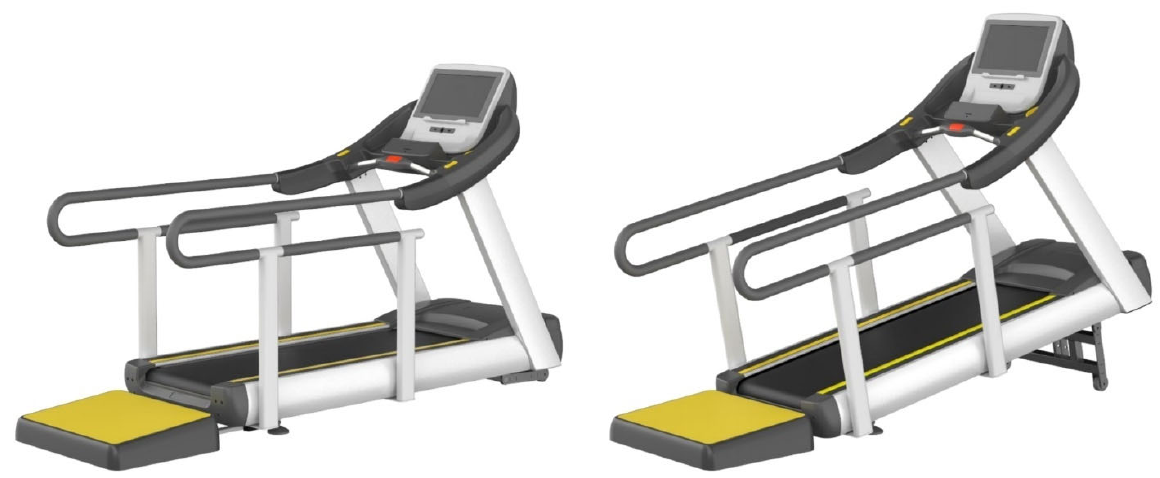
Figure 17. Main features of the treadmill design .